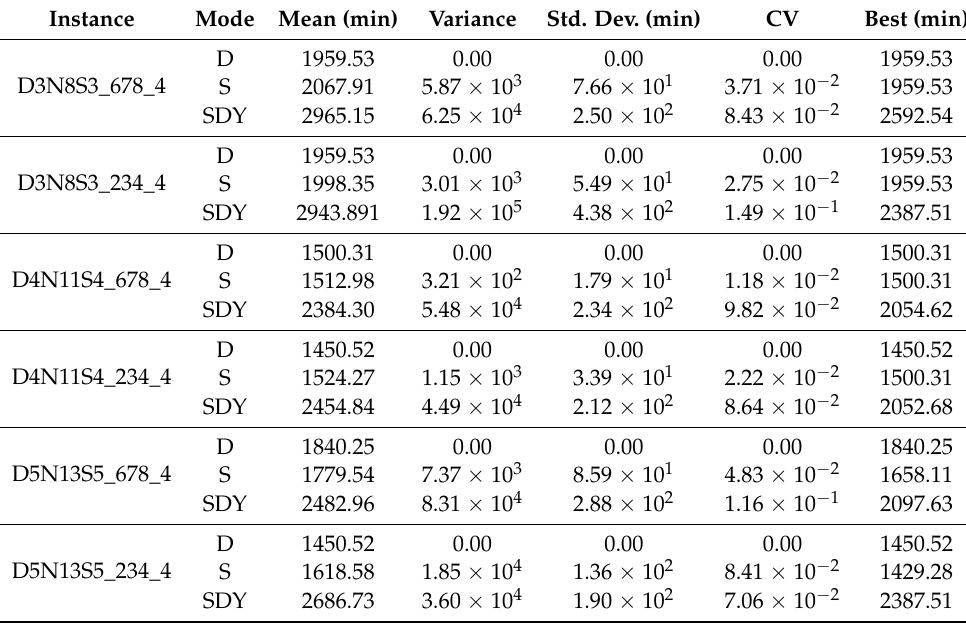
Table 12. Results of Total Travel Time with (Maximum) 4